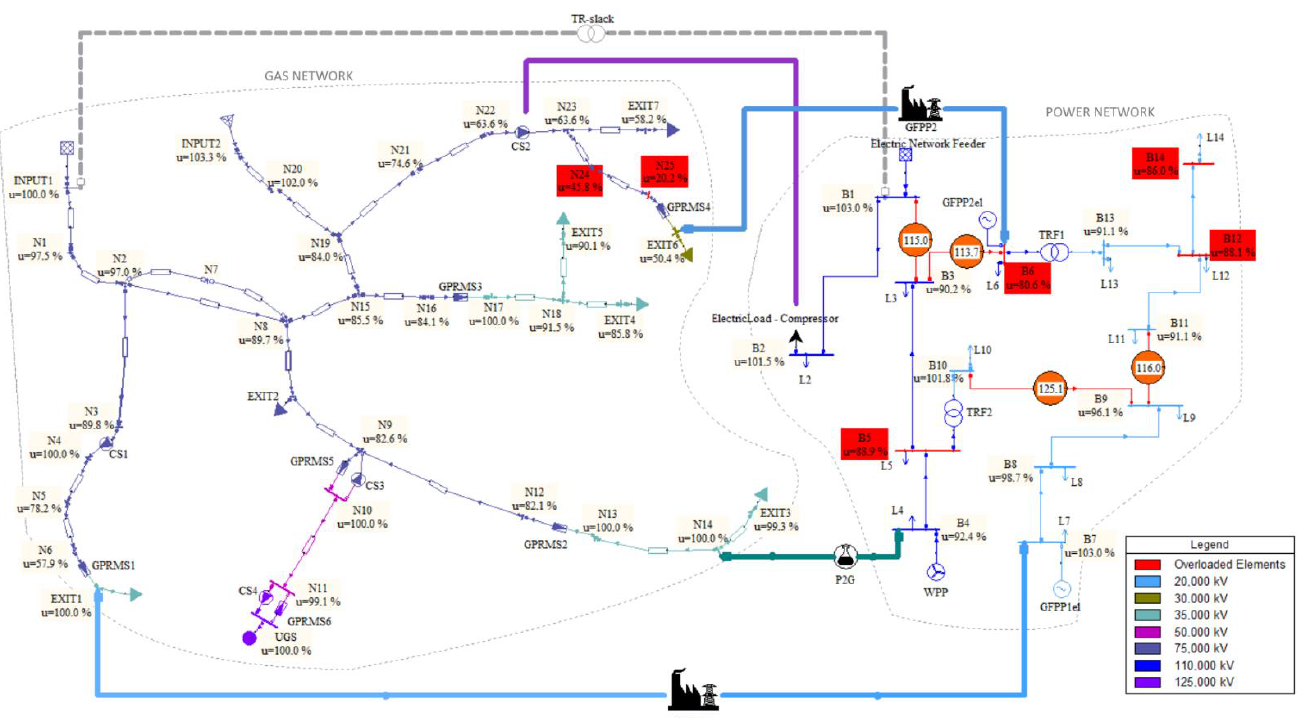
Figure 5. Analyze the influences of the CS1 operation state on the security of the power network supply UGS injection process.